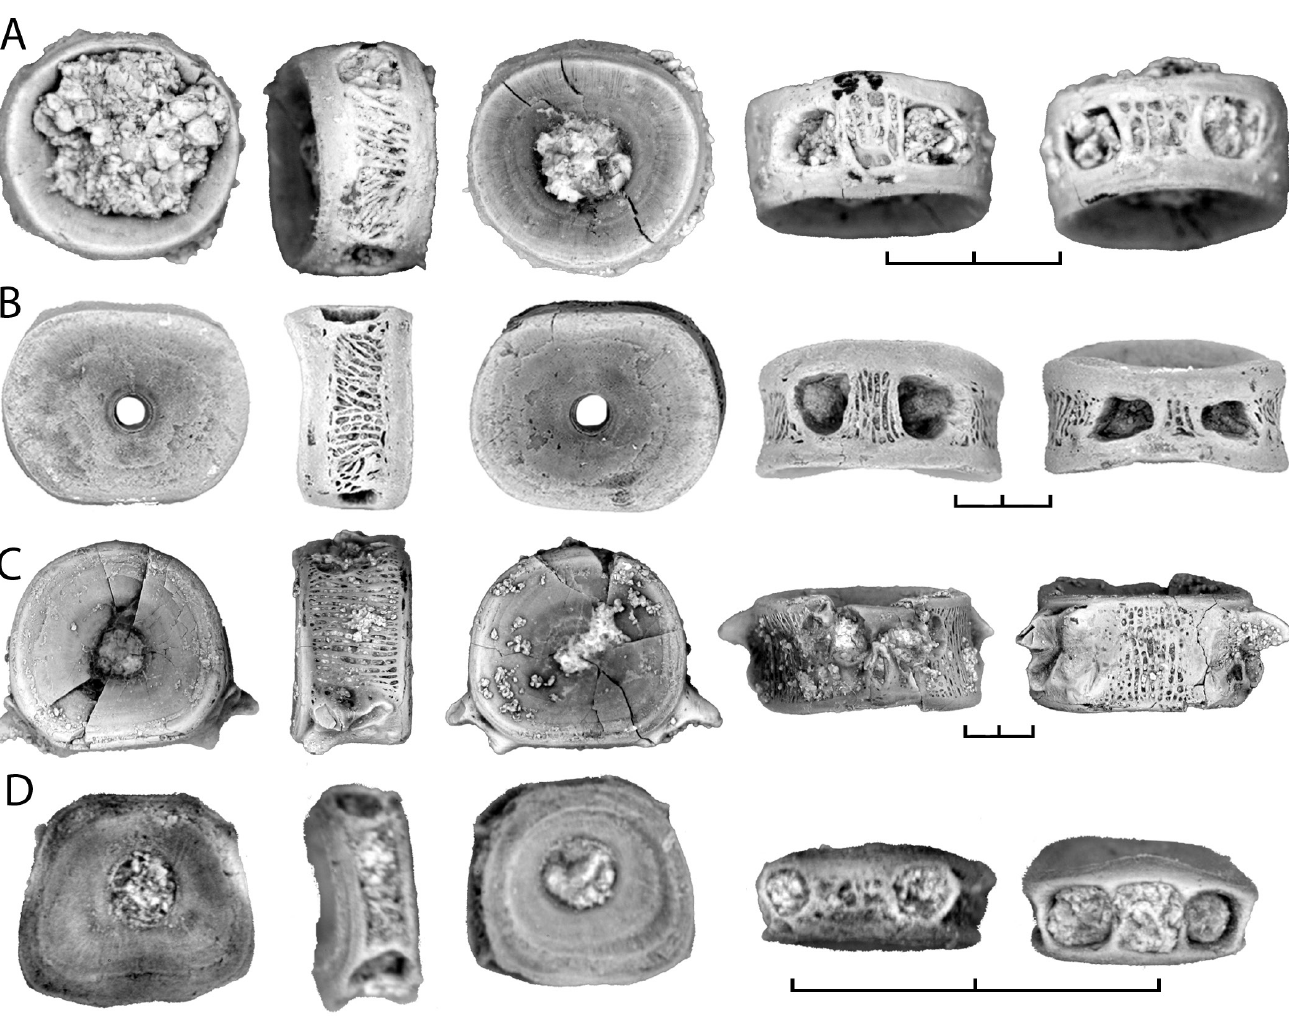
Figure 8. Elopomorpha gen. indet. centra from the Milk River Formation compared with small elopomorph centra from the Turonian of Utah and Campanian of Alberta. A) Elopomorpha gen. indet. centrum from Milk River Formation, UALVP 48863. B) Elopomorpha gen. indet. centra from the late Campanian Dinosaur Park Formation, TMP 97.19.11. C) Elopomorpha gen. in - det. centrum from the Cenomanian Dakota Formation of Utah, specimen MNA V10321. D) Elopomorpha gen. indet. centrum from the Turonian Smoky Hollow Member of the Straight Cliffs Formation, specimen OMNH 31248. Centra shown in anterior, left lateral, posterior, dorsal and ventral views. C from Brinkman et al. (2014: fig. 10.14B)Scale bar equals 2